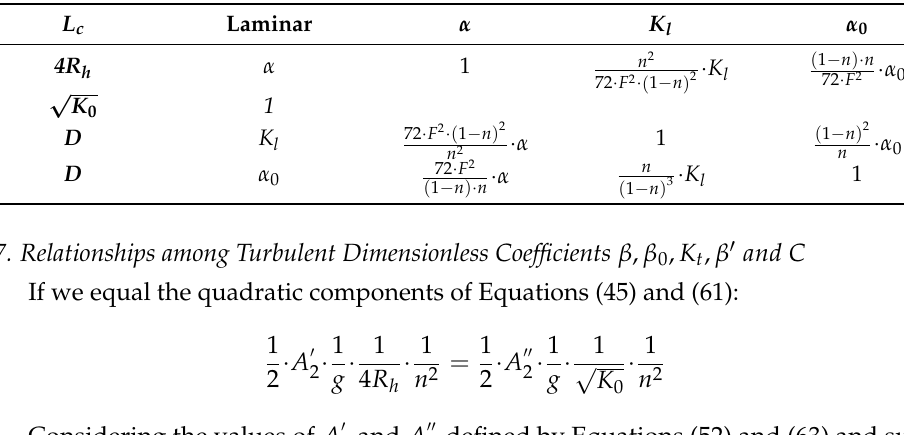
Table 3. Relationships among the laminar dimensionless